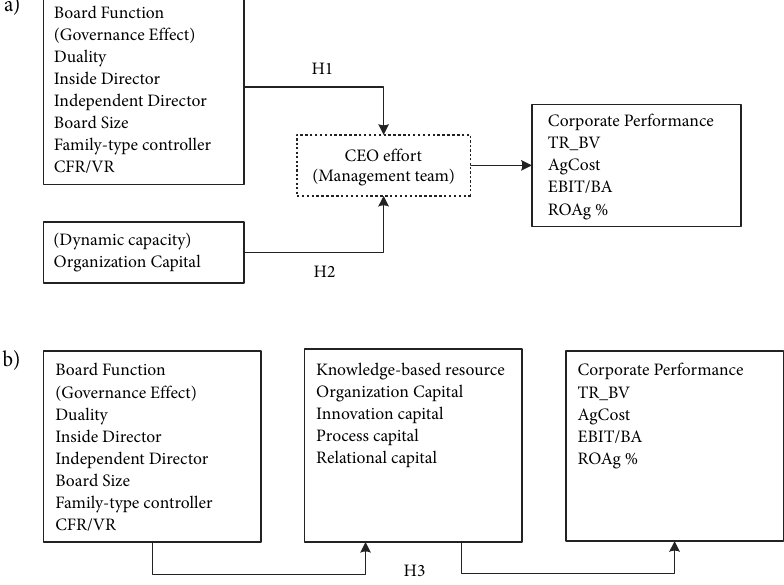
Board Function (Governance